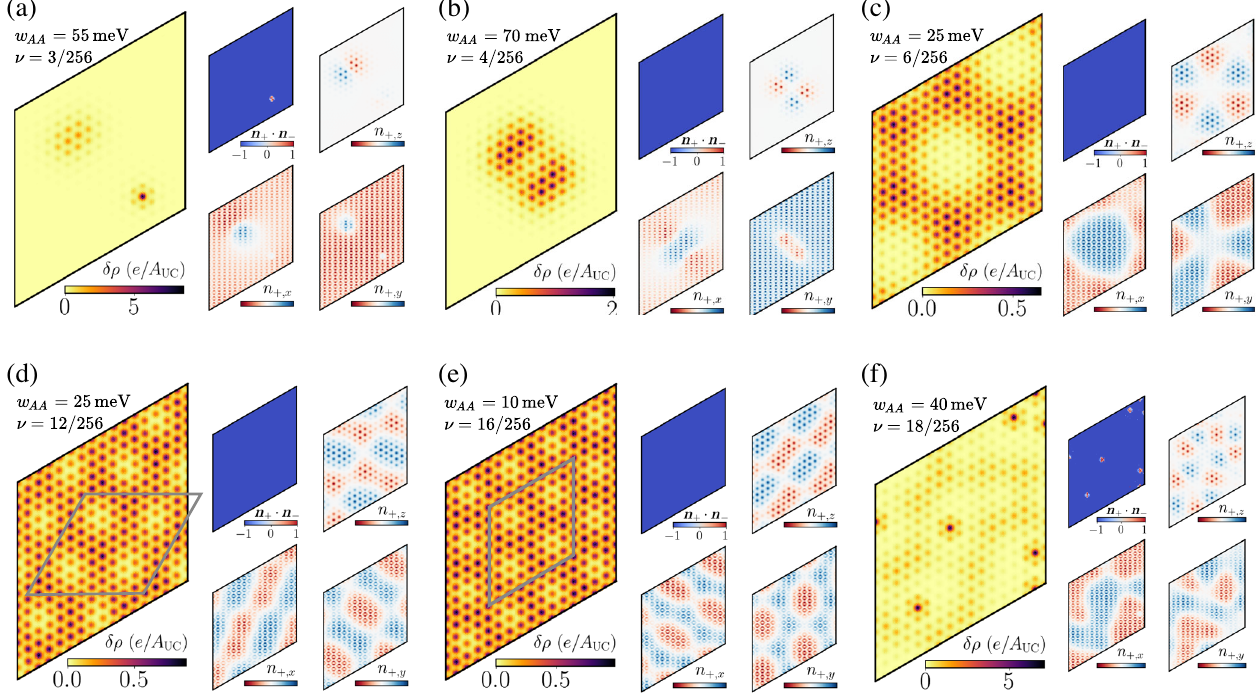
FIG. 7. Skyrmion composites and crystallization (spinless ν ¼ 0 ). Charge density δρ , inter-Chern pseudospin alignment n pseudospin orientation n for different numbers of electrons above charge neutrality ν ¼ 0 in the spinless model. Emergent supercells þ for the double-tetarton lattice are highlighted in gray. All pseudospin densities are diagonal in microscopic layer or sublattice. System size is 16 × 16 with the average